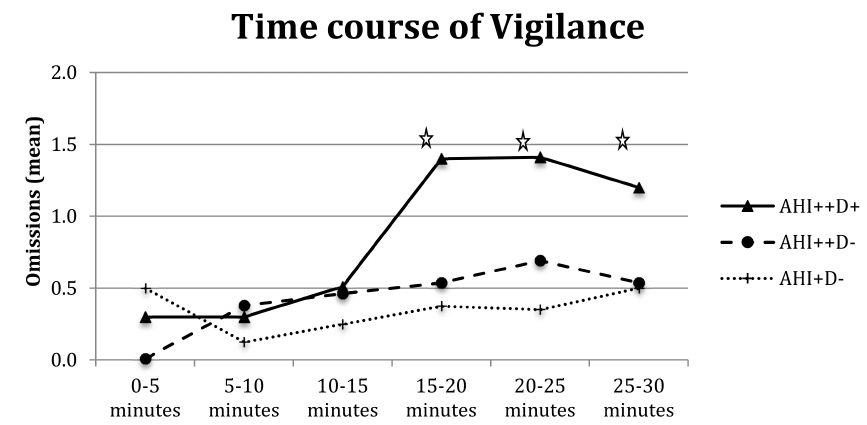
Figure 5. Omissions in six intervals of vigilance test for three groups of OSA